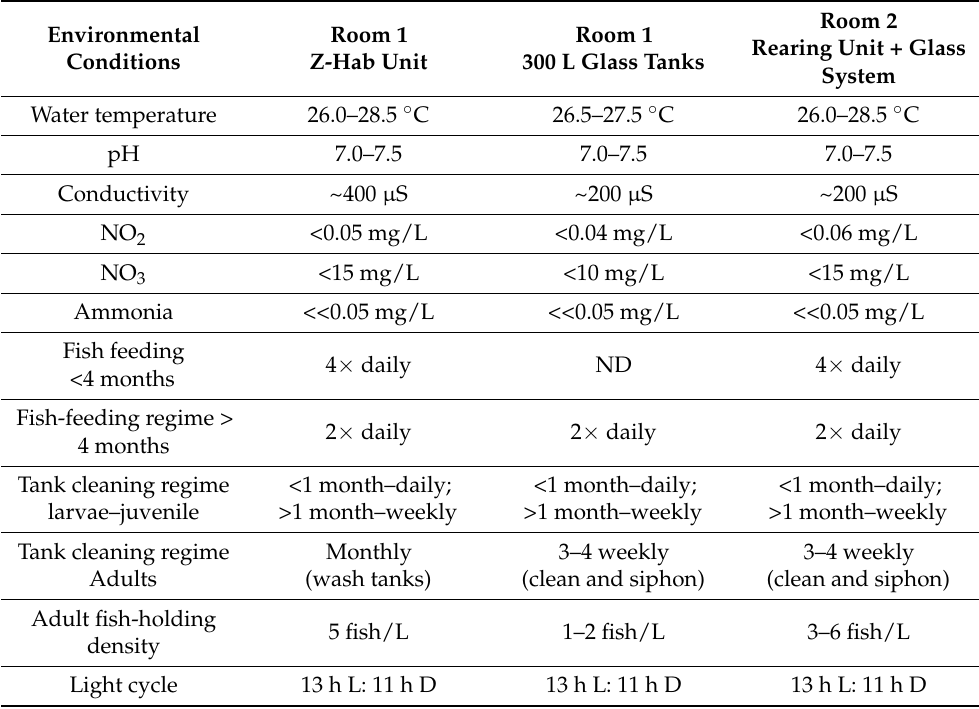
Table 1. Summary of the water quality parameters and husbandry routine in the